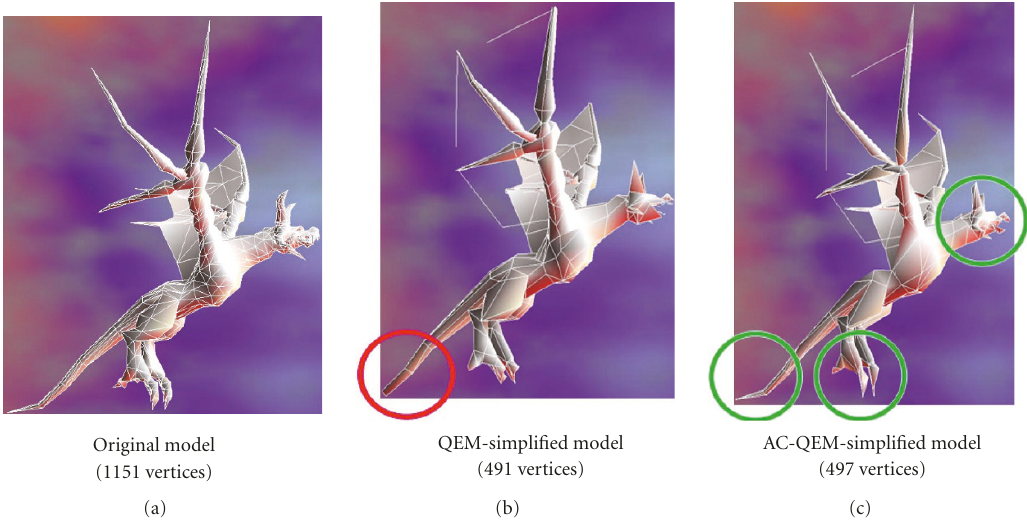
Figure 8: AC-QEM versus QEM: qualitative results for the dragon model.